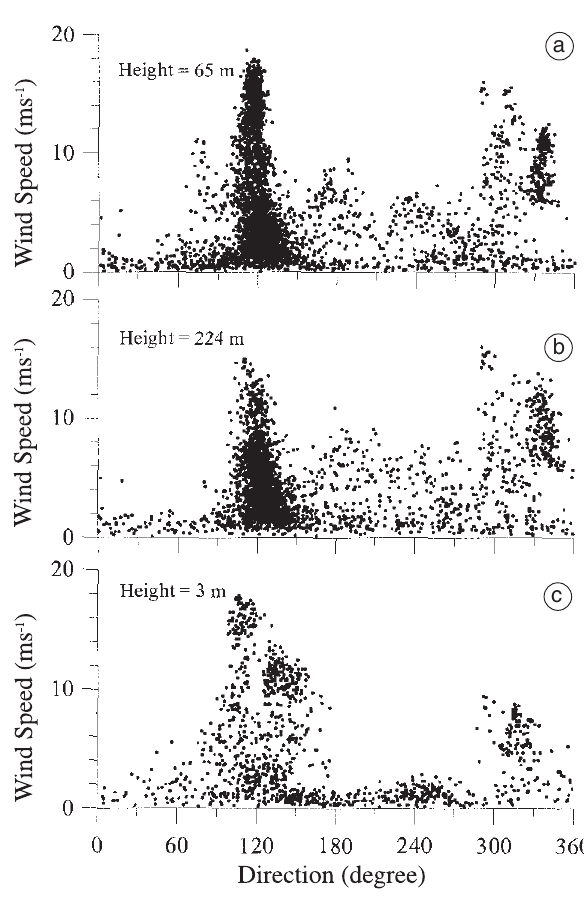
Fig. 2a-c. Scatter plot of the wind speed versus the wind direction during ARTIST at 65 m (a) and 224 m (b) for sodar and at 3 m for sonic data